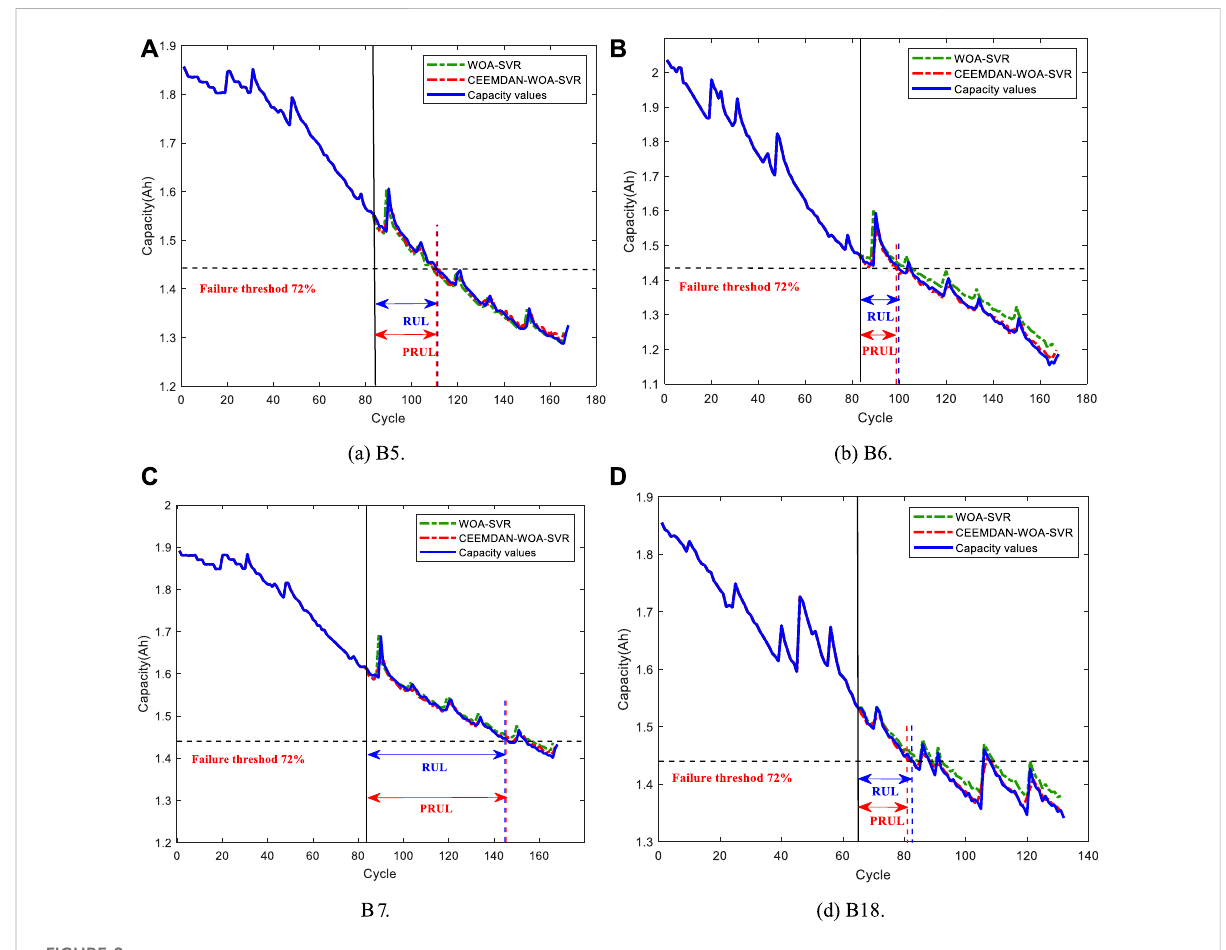
FIGURE 8 Prediction results of WOA-SVR and CEEMDAN-WOA-SVR (training samples with 50% cycle data). (A) B5, (B) B6, (C) B7, (D)